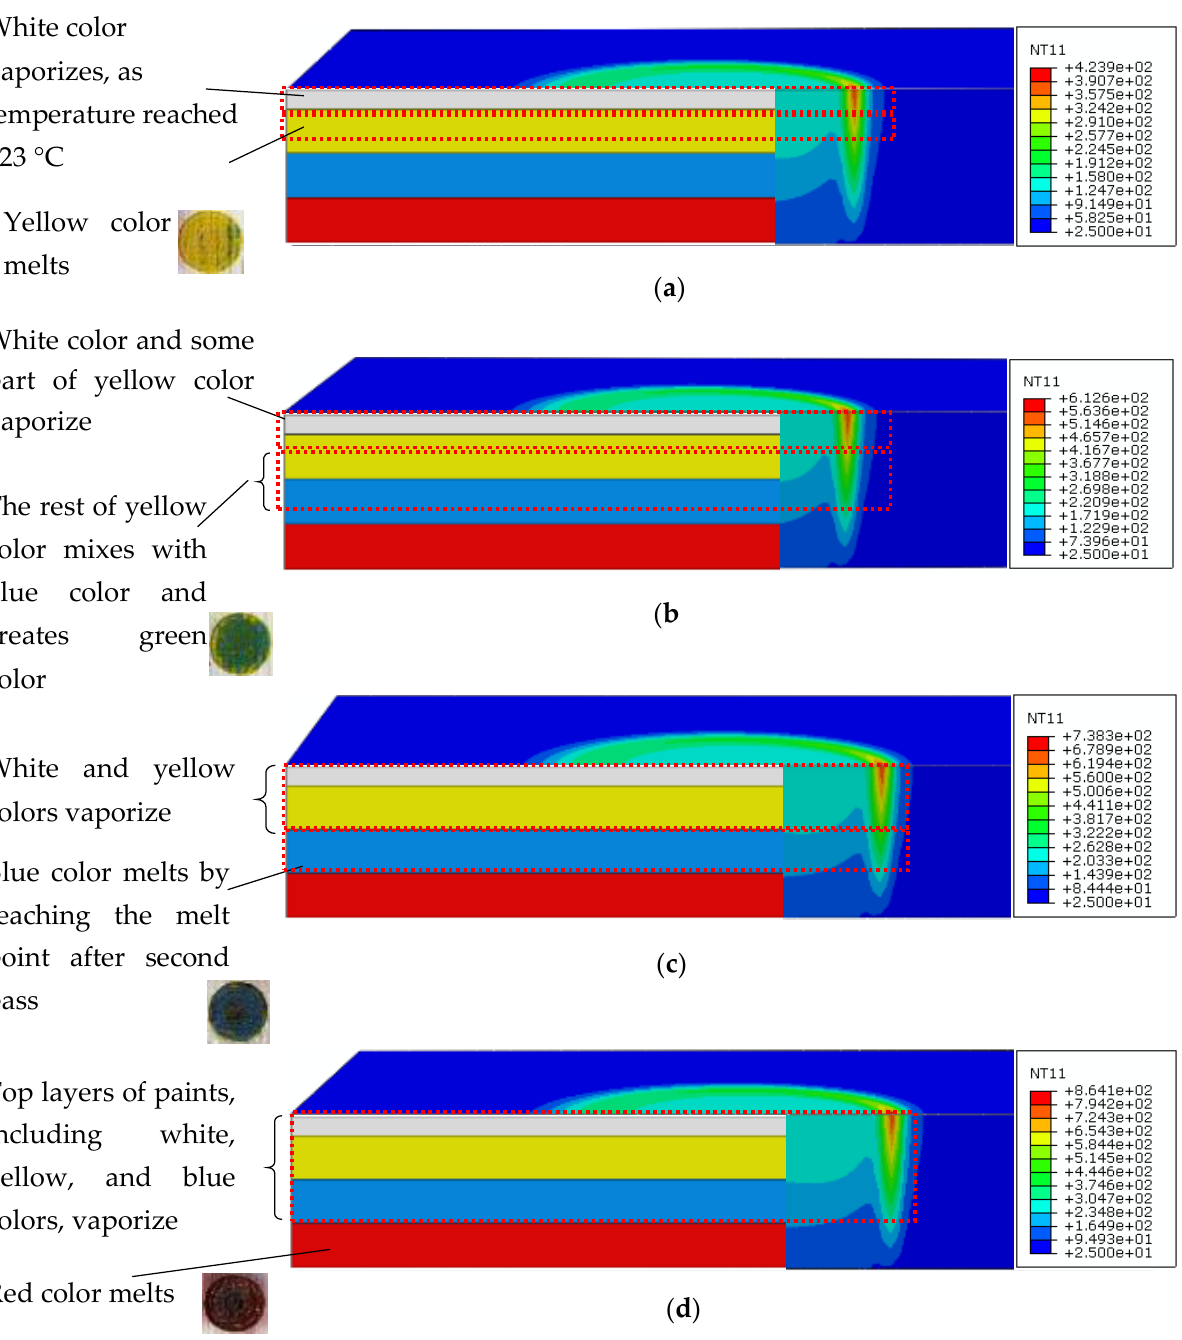
Figure 25. Temperature gradient for each color at last time increment: ( a ) yellow color, ( b ) green color, ( c ) blue color, and ( d ) red color.